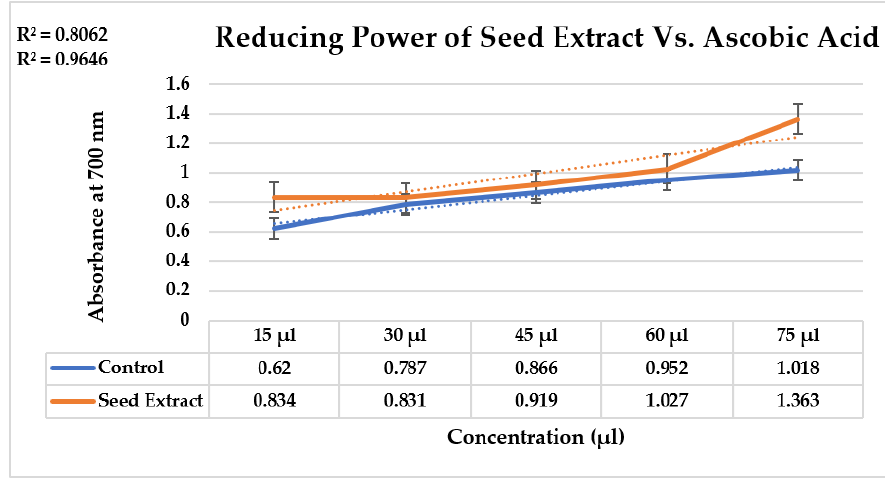
Figure 1 . Determined reducing power of seed extract with control , i.e., ascorbic acid , showing the Figure 1. Determined reducing power of seed extract with control, i.e., ascorbic acid, showing the strong relationship , thus showing the capability of seed extract to reduce the ZVI - NPs . strong relationship, thus showing the capability of seed extract to reduce the ZVI-NPs.